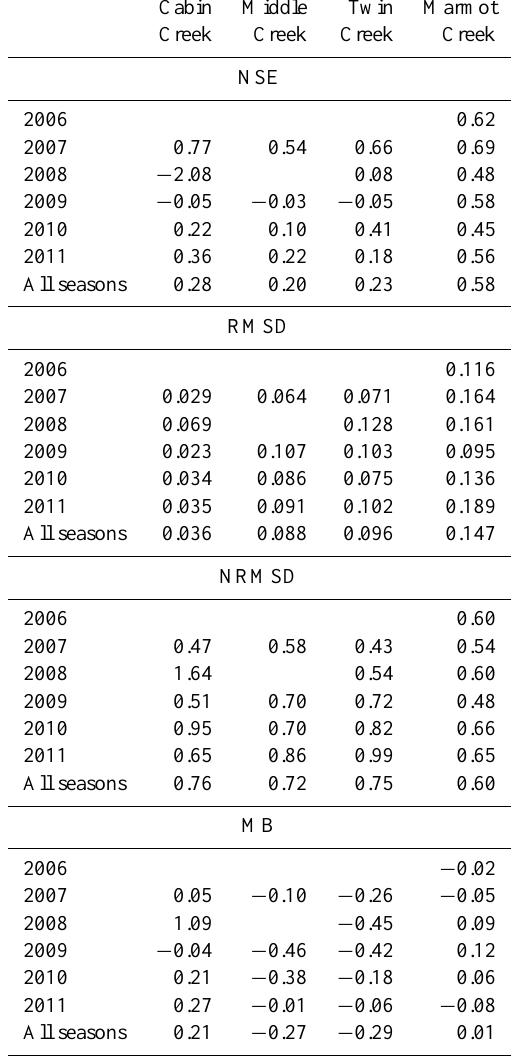
Table 5. Evaluation of the simulated daily mean streamflow dis- charge for Cabin Creek, Middle Creek, Twin Creek, and Marmot Creek using the Nash–Sutcliffe efficiency (NSE), root mean square difference (RMSD, m 3 s − 1 ), normalised RMSD (NRMSD), and model bias